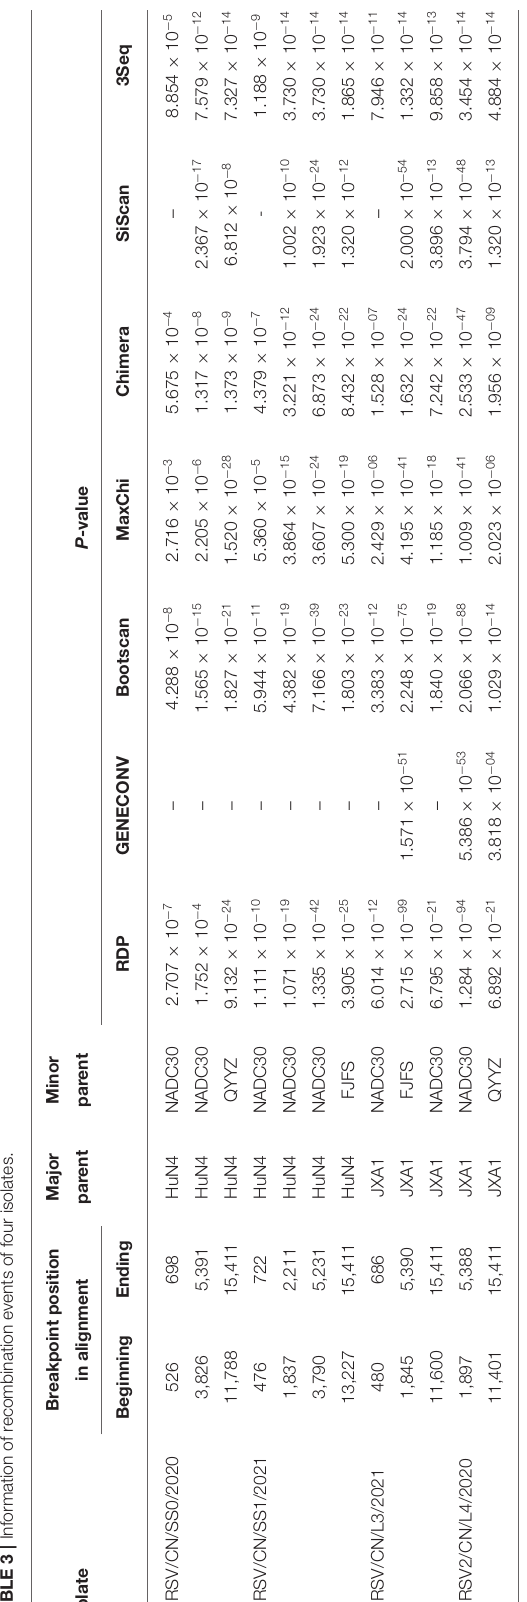
Supplementary Figure 2 ). Additionally, the phylogenetic trees were further confirmed using SimPlot v3.5.1 and statistically incongruent phylogenetic trees ( Figure 4